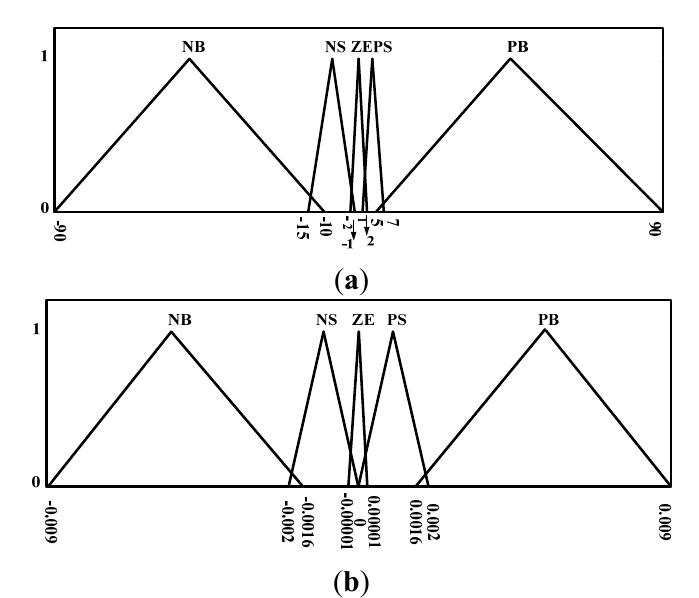
Figure 28. Fuzzy rules for Algorithm (vi).